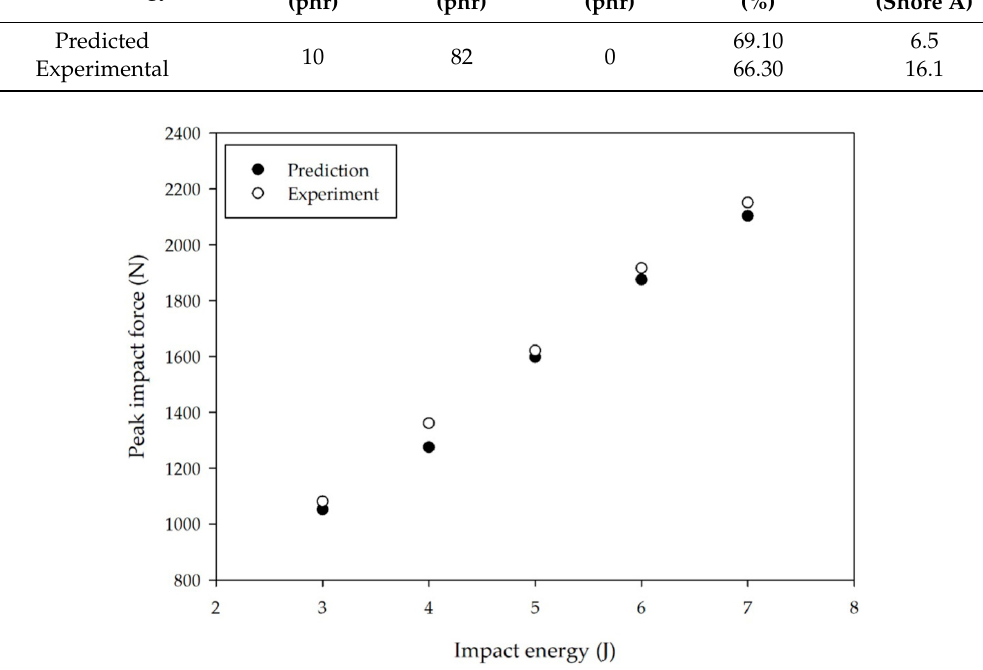
Figure 7. Relationship between peak impact force and impact energy from experimental data and model predictions (see legend).